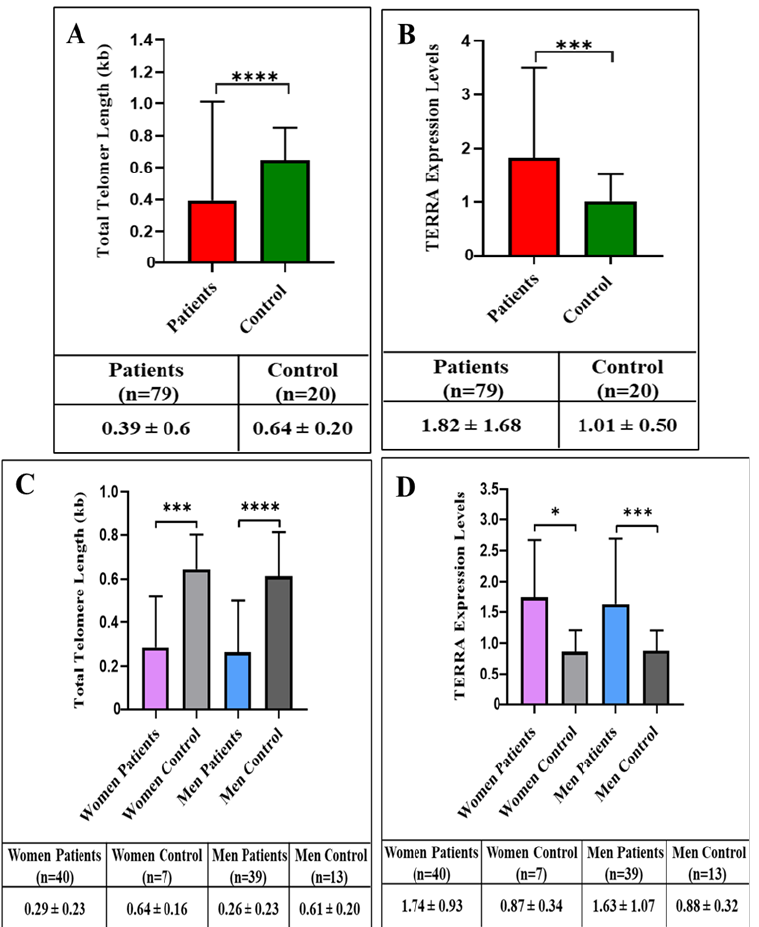
Figure 1. Determination of telomere length (PCR; see Methods) from blood samples from the group of patients diagnosed with ADPKD and from the control group. Telomere length is significantly shorter in patients than in controls (**** p < 0.0001) ( A ). TERRA expression levels in patients and control groups. TERRA expression levels were determined in the DNA:RNA hybrid fraction (see Methods) extracted from blood cells. Significant differences in TERRA level were found in patients and controls (*** p = 0.0009) ( B ). Telomere lengths were compared between patient and control groups by gender. Telomere length of female (*** p = 0.0004) and male (**** p < 0.0001) patients was found to be shorter than that of controls. ( C ) TERRA expression levels were compared between patient and control groups by gender. TERRA expression levels in female (* p = 0.0102) and male (*** p = 0.0004) patients were found to be increased compared to controls. All data are plotted as mean ± standard deviation ( D